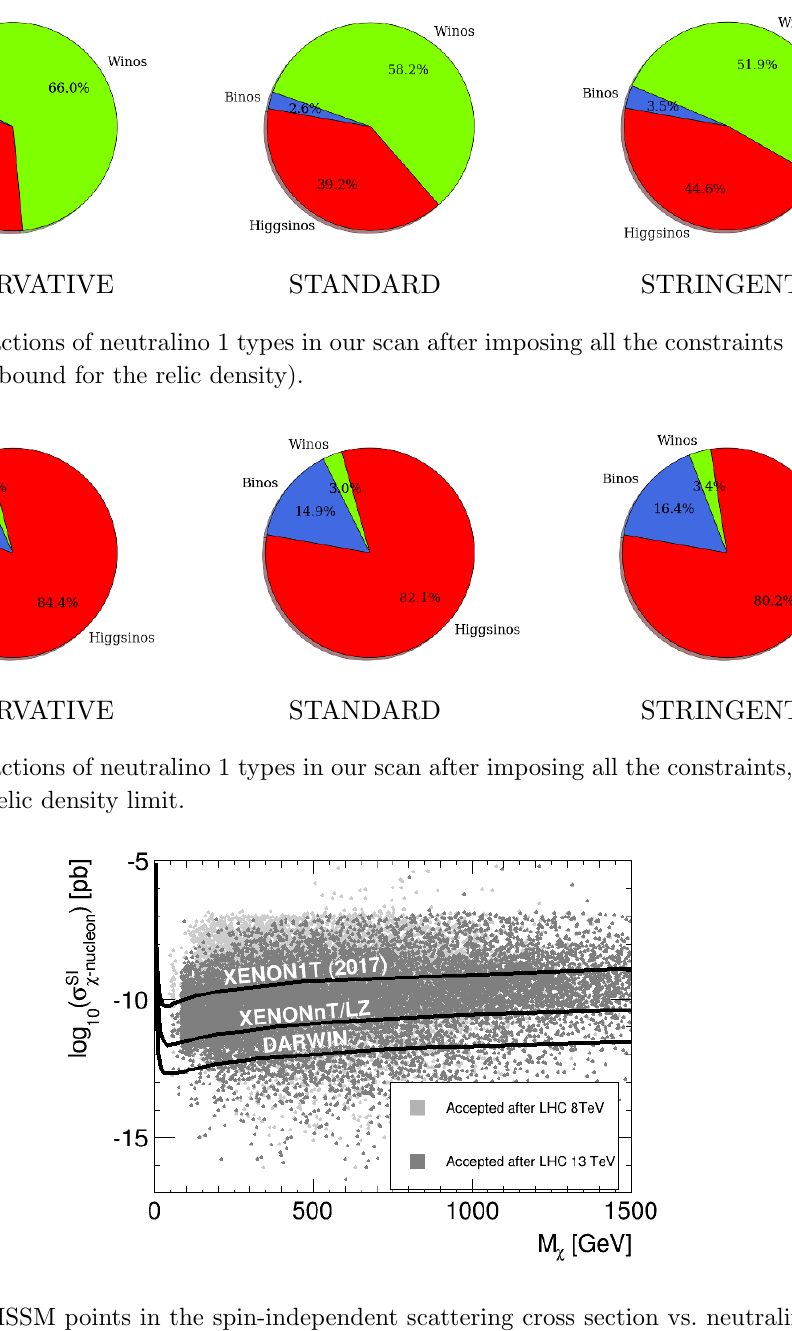
Figure 25 . pMSSM points in the spin-independent scattering cross section vs. neutralino 1 mass parameter plane. The current XENON1T upper limit is superimposed together with the prospective limits of XENONnT/LZ and